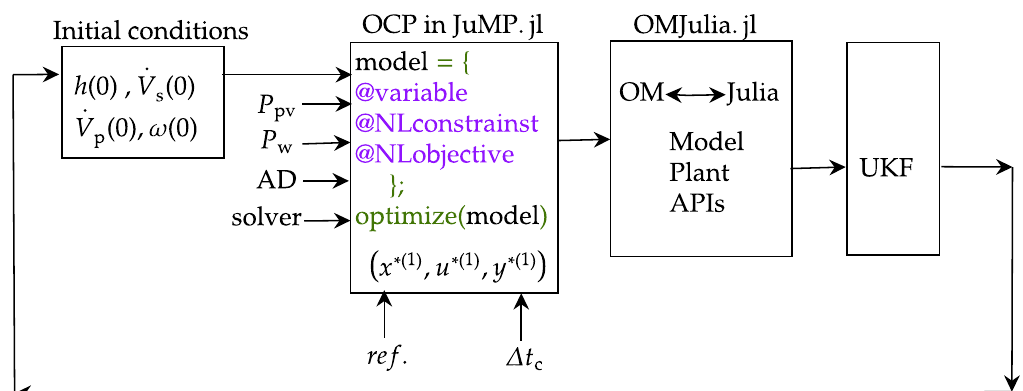
(cid:16) (cid:17) x ∗ ( 1 ) , u ∗ ( 1 ) , y ∗ ( 1 ) represents first